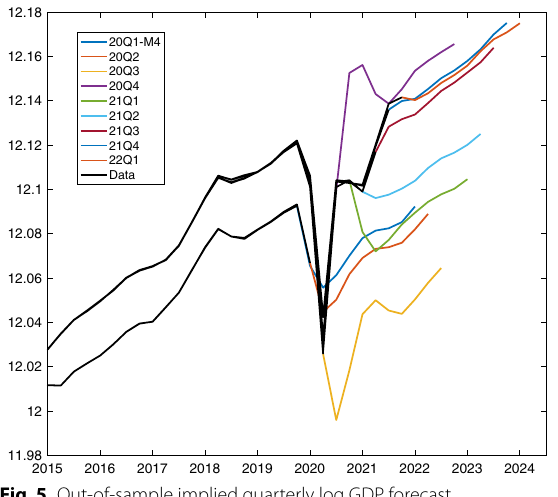
Fig. 5 Out-of-sample implied quarterly log GDP